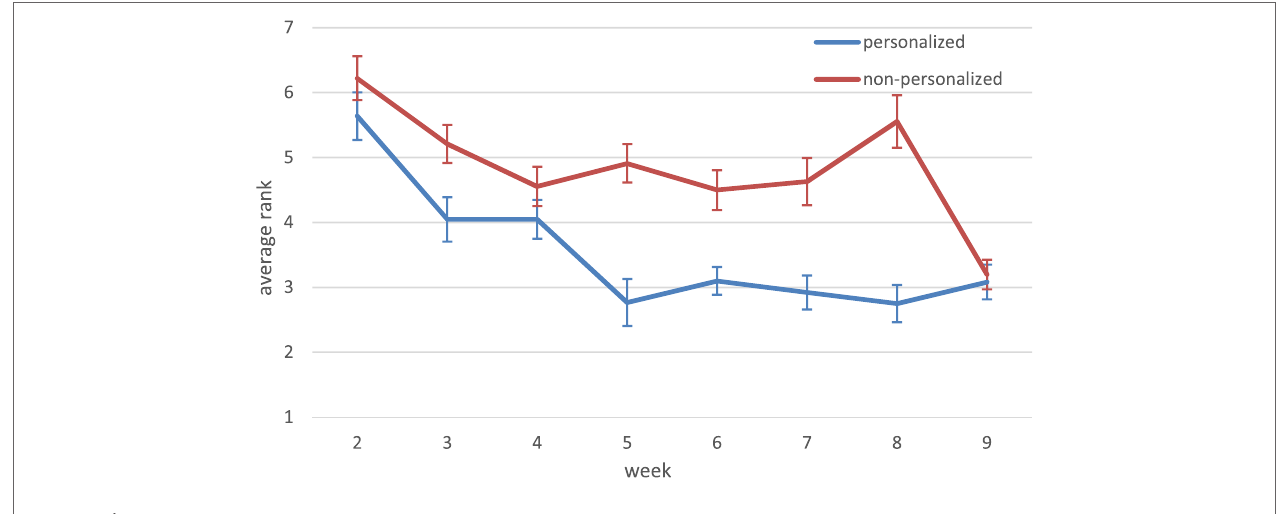
FigUre 6 | average rank of clicked items .